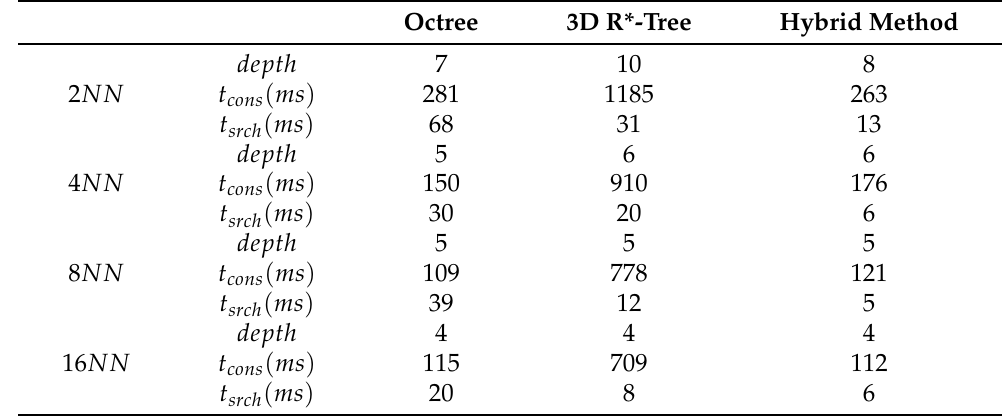
Figure 9. Real − world Point Cloud data. Table 1. Comparison of experimental data. t cons represents the time used by constructing structure, t srch represents the time used by kNN